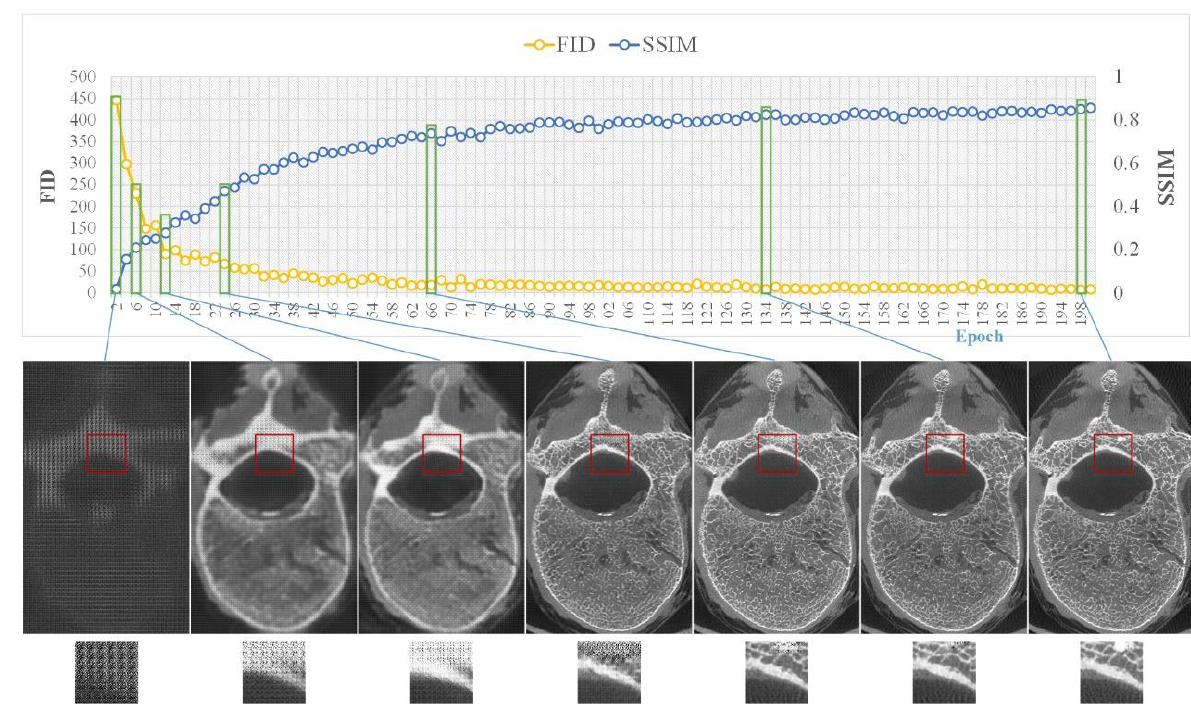
Figure 5. Model training, where the top side shows the changes in the two metrics (i.e., SSIM and FID) during training and the bottom side shows sample images from several key epochs.